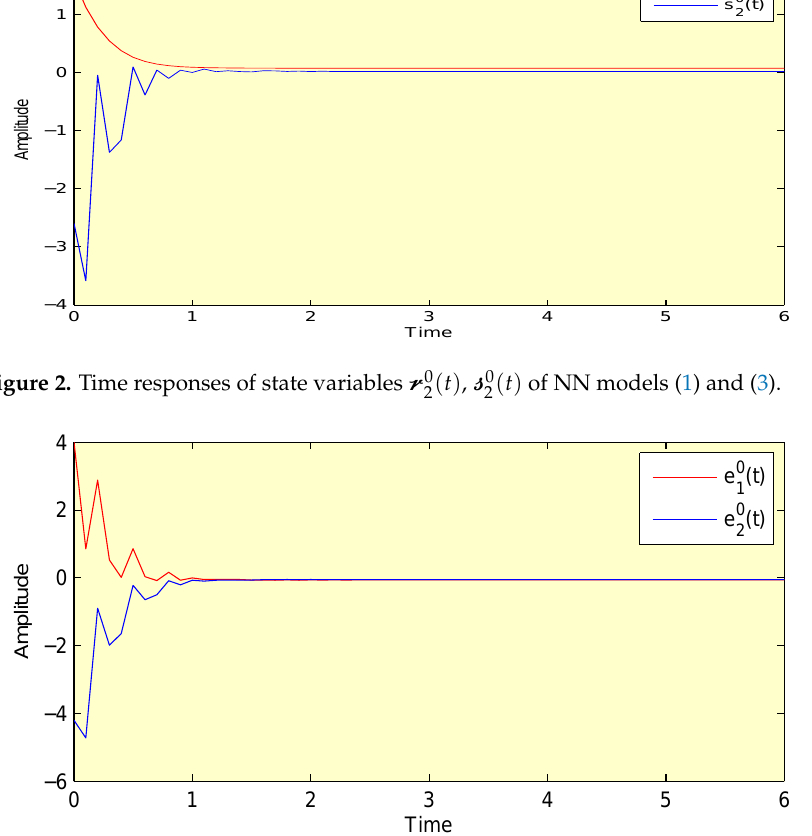
Figure 3. Synchronization curves of state variables (cid:101) 0 troller